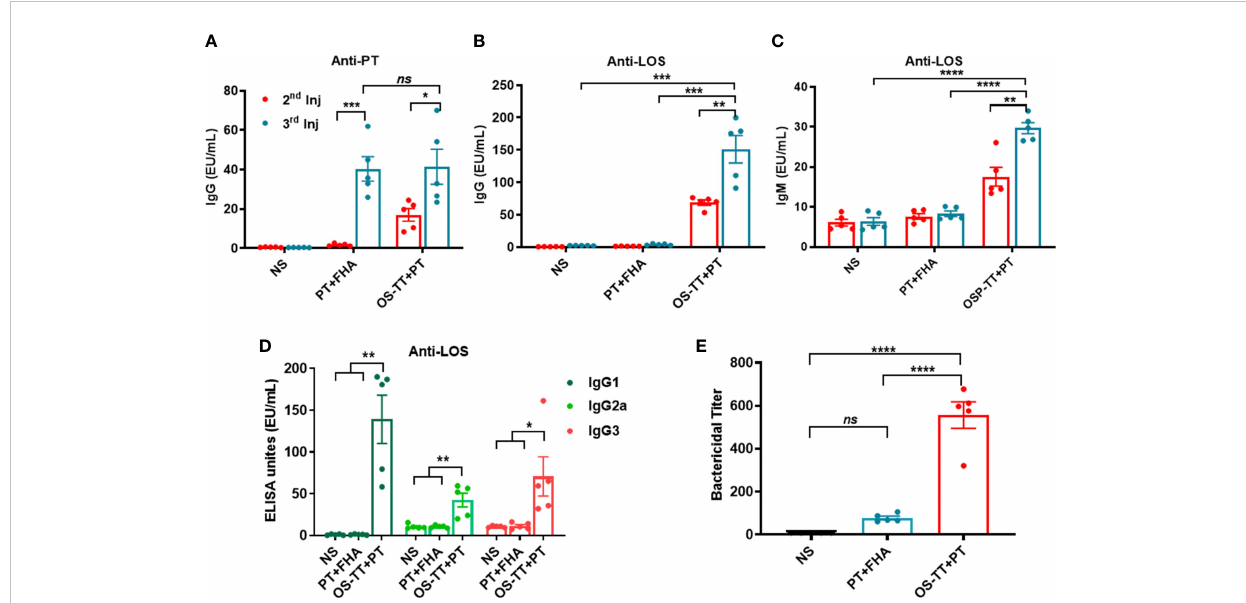
FIGURE 4 Antigen-speci fi c serum antibody responses in mice after immunization. (A) IgG titers against PT were measured in the serum of BALB/c mice immunized with NS, PT+FHA, or OS-TT+PT. (B) Anti-LOS IgG. (C) Anti-LOS IgM. (D) .IgG subclass titers (IgG1, IgG2a, IgG3) against LOS from B. pertussis 58031. (E) Bactericidal titer of sera against B. pertussis . NS: normal saline. Data shown are from one representative of three independent experiments. Data in A – E (n=5) are shown as the mean ± SEM, and signi fi cance was calculated using a one-way ANOVA with multiple comparison